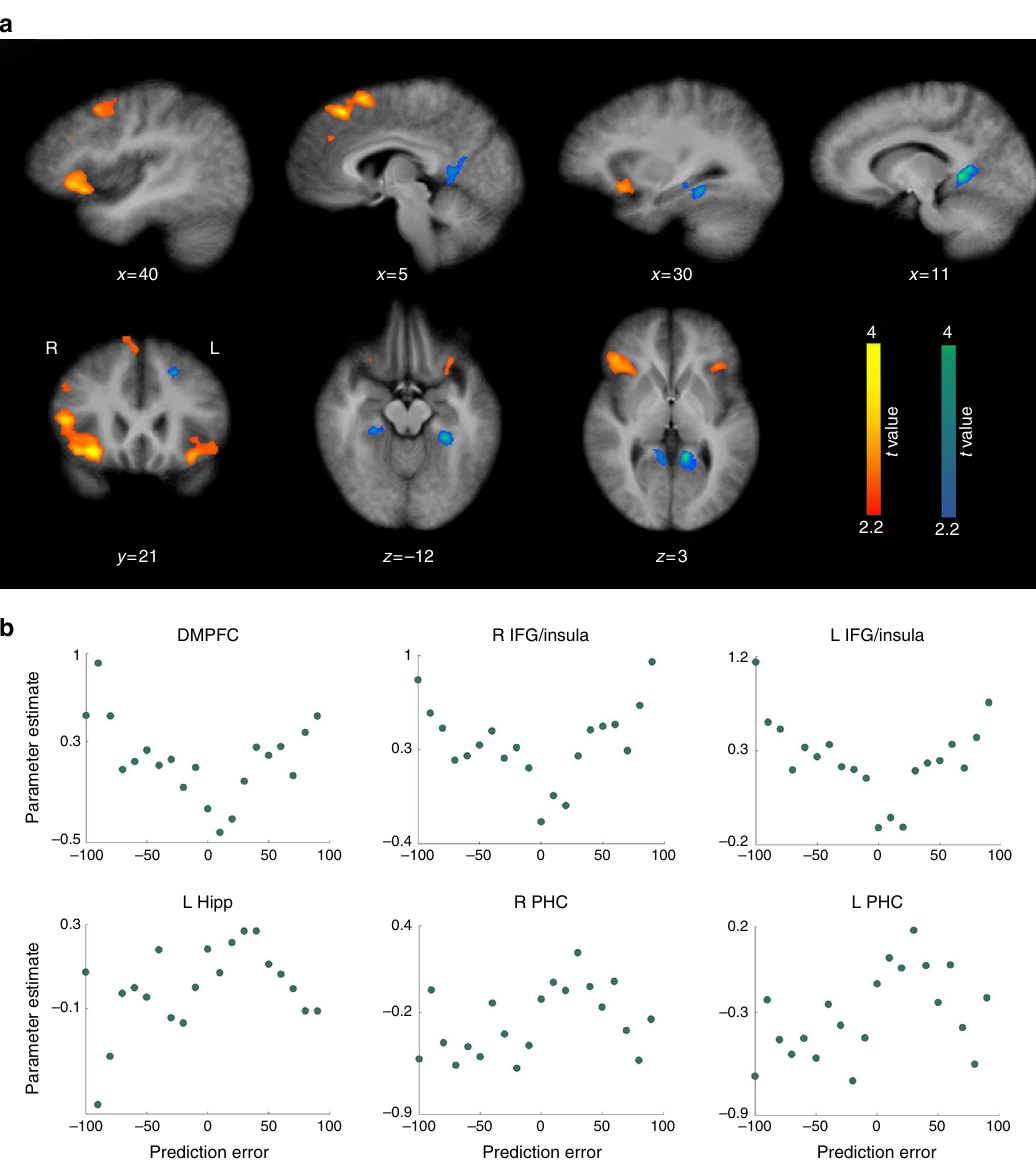
Fig. 4 Brain regions correlating with absolute PE magnitude (salience). a Large clusters in IFG (extending to anterior insula) and DMPFC bilaterally, as well as DLPFC (on the right) were observed to positively correlate with unsigned PE magnitude. A number of activations (in blue) in the MTL, mainly in the parahippocampal gyri (PHC), inversely correlated with unsigned PE magnitude (Supplementary Table 2). b Activity in these regions parametrically varied with PE magnitude on each trial, such that the greatest responses were elicited by large PE events of both positive and negative valence (feedback to correct answers stated with low con fi dence, and incorrect answers with high con fi dence), and the smallest responses by low PE feedback events (following high con fi dence correct, and low con fi dence incorrect answers). The reverse relationship was observed in the blue activation clusters. Plots depict average single-trial beta estimates for each PE value in selected